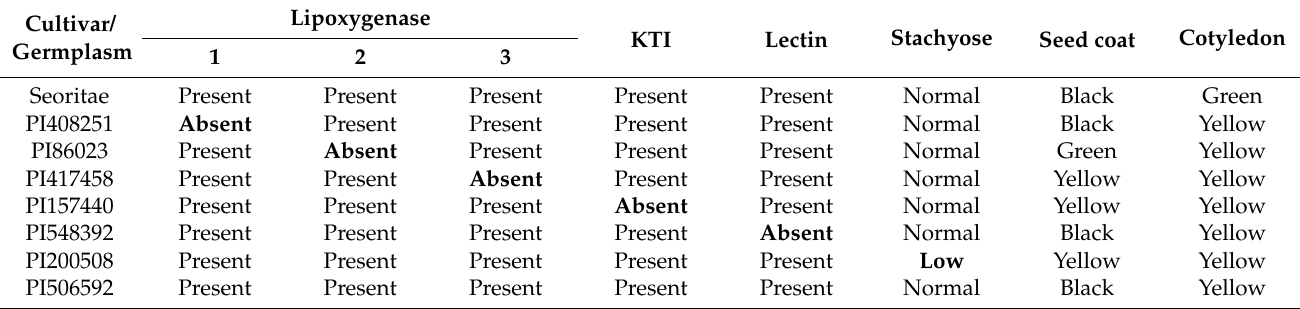
Table 1. Phenotypes of the eight parents used in this experiment for lipoxygenase, Kunitz trypsin inhibitor (KTI), lectin, stachyose, seed coat, and cotyledon (Bold letter: recessive trait).